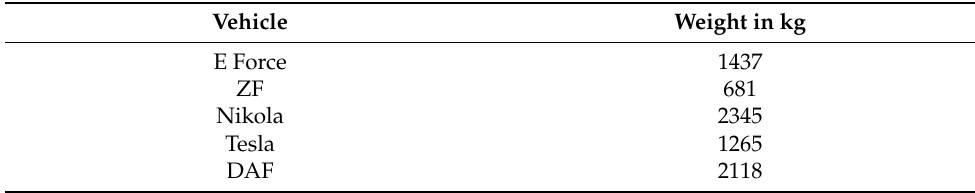
Table 4. Weight of the electrical machines based on a linear regression model